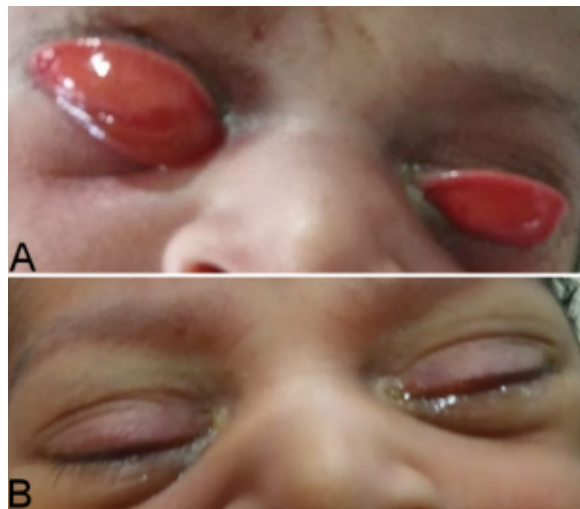
Figure 1: A) One-day-old neonate at presentation with bilateral ectropion, with the right eye showing a more severe chemosis than the left eye; B) On day 5 of conservative treatment, showing complete resolution of